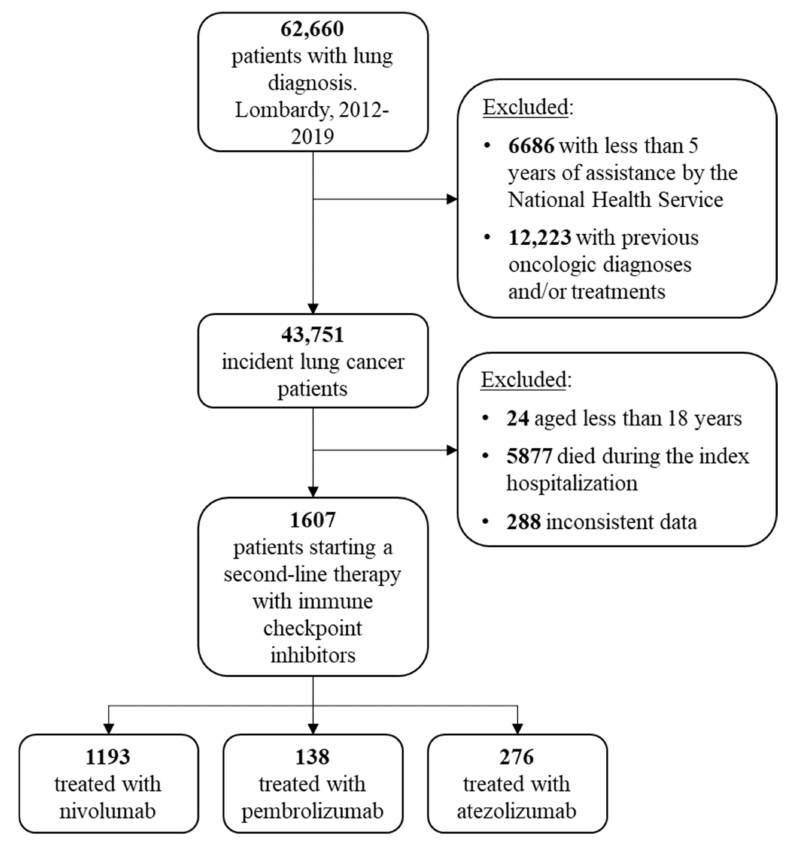
Figure 1. Flowchart of cohort